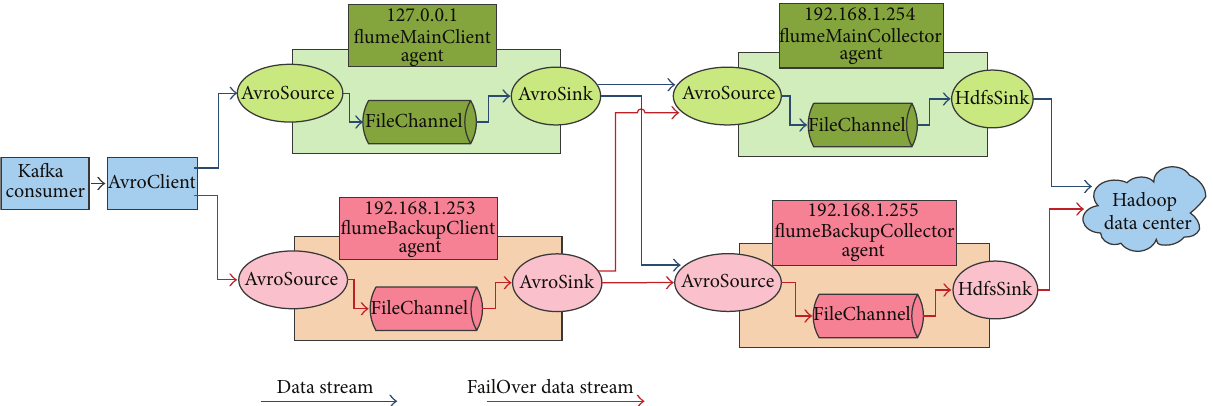
Figure 14: The architecture of FlumeNG in X73 uHealth system.